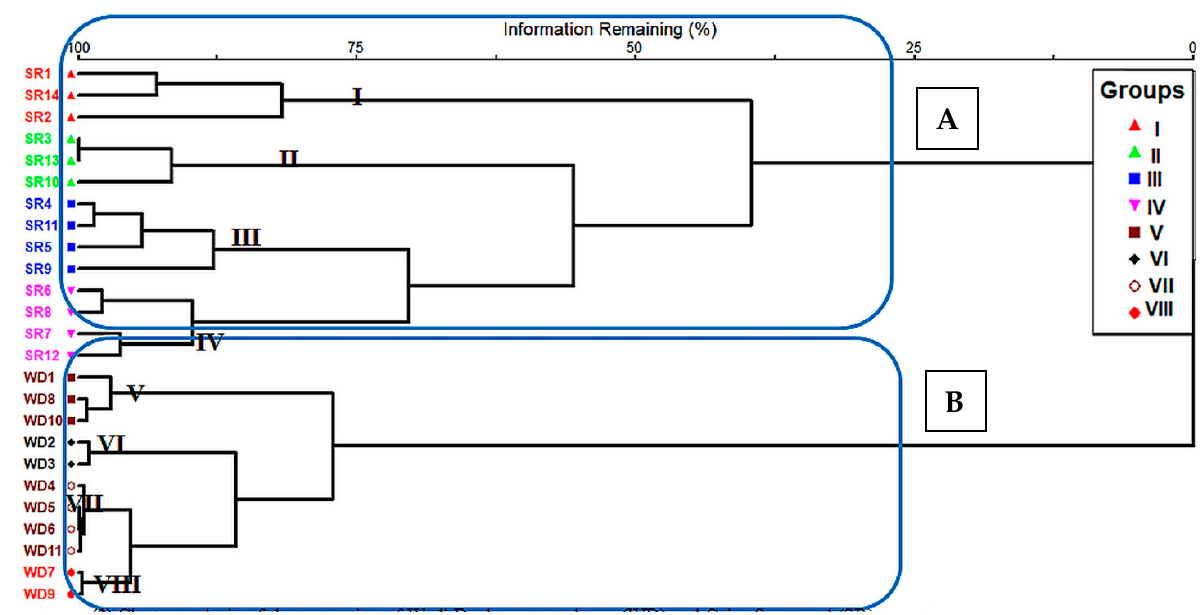
Figure 3. Cluster analysis of the vegetation of the Cairo ‐ Suez road ( A ) and Wadi Degla protected area ( B ), with their vegetation groups (I–VIII). Table 2. Summary of indicator species analysis (ISA) showing the most significant indicator species per vegetation group (I–VIII). Figures are indicator values (IV% of perfect indication based on combining values for relative abundance and relative frequency, and p -values of most significant indicator species per vegetation group. p -value = Monte Carlo test of significance of the observed maximum indicator value for each species, based on 999 randomizations). The highest indicator values are in bold